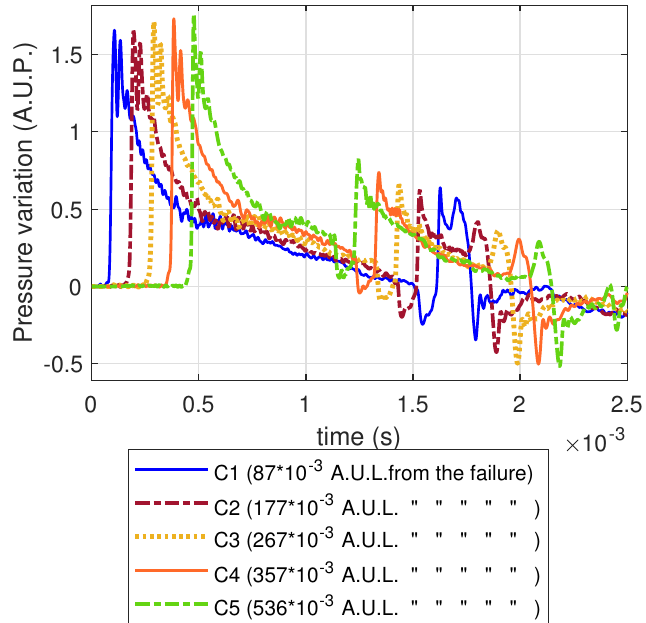
Figure 8. Simulated pressure at different positions in the main section.